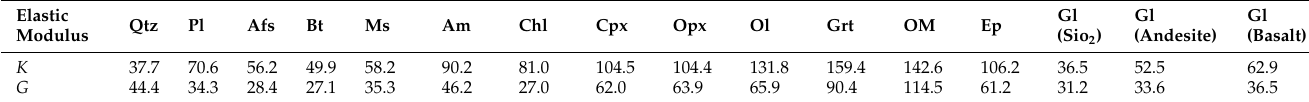
Table 2. Bulk and shear moduli of constituents of the studied igneous